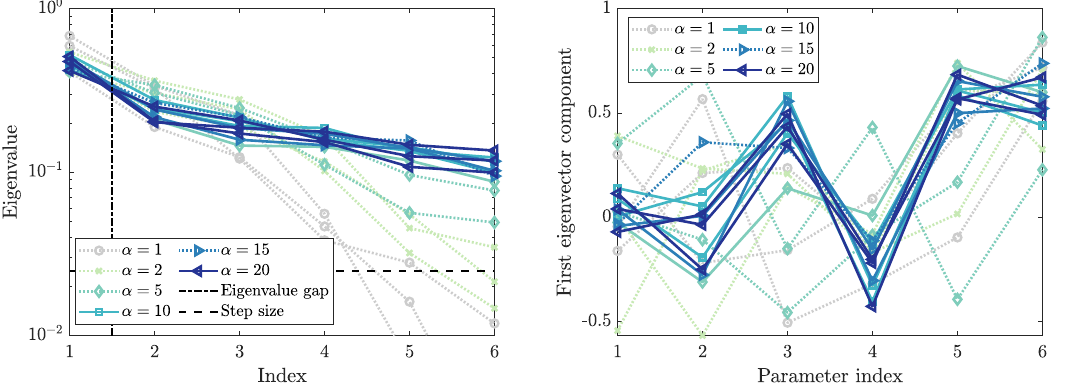
Figure A7. Eigenvalues and first eigenvector of the matrix C for the new range of the personal space strength parameter. Runs that identify a one-dimensional subspace are shown with solid lines, in some runs a 5-dimensional subspace is identified (dotted). The parameter index is mapped as follows: 1—control parameter, 2—free-flow speed mean, 3—free-flow speed standard deviation, 4—number of agents, 5—bottleneck width, 6—personal space strength. The index for the eigenvalue plot refers to the directions identified by the